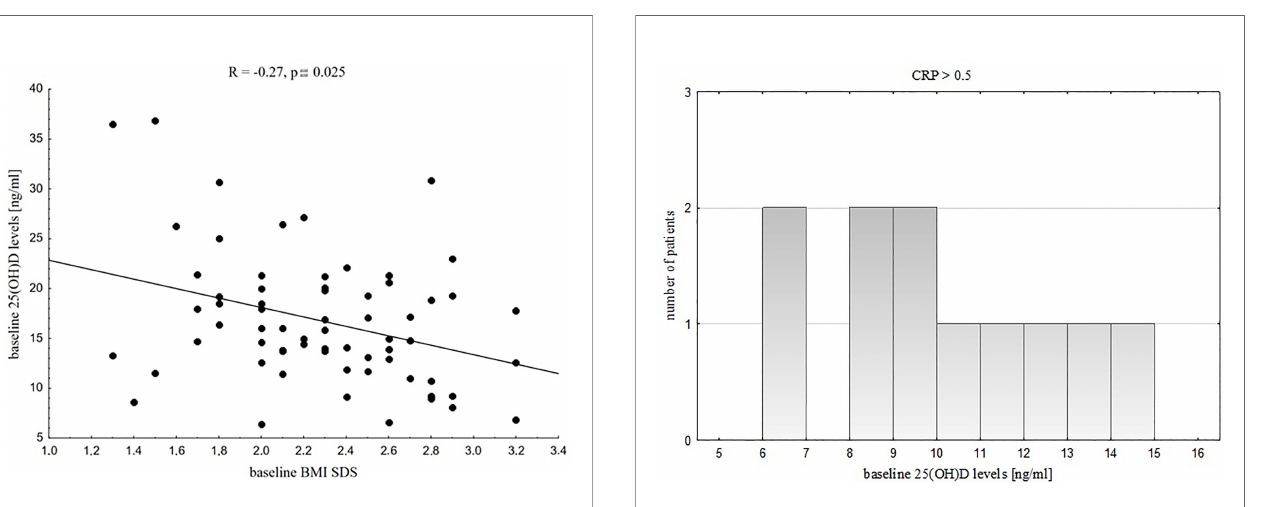
FIGURE 1 | Correlation between baseline 25(OH)D levels and baseline BMI SDS in the whole study group.